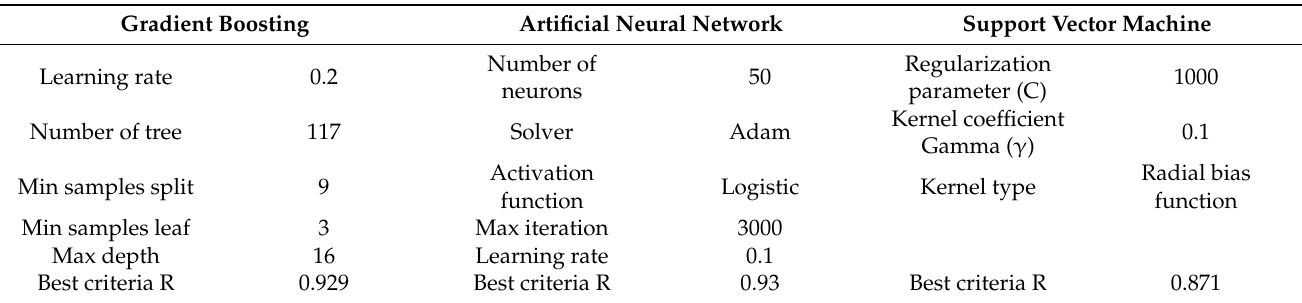
Table 3. Optimum hyper-parameters of ML